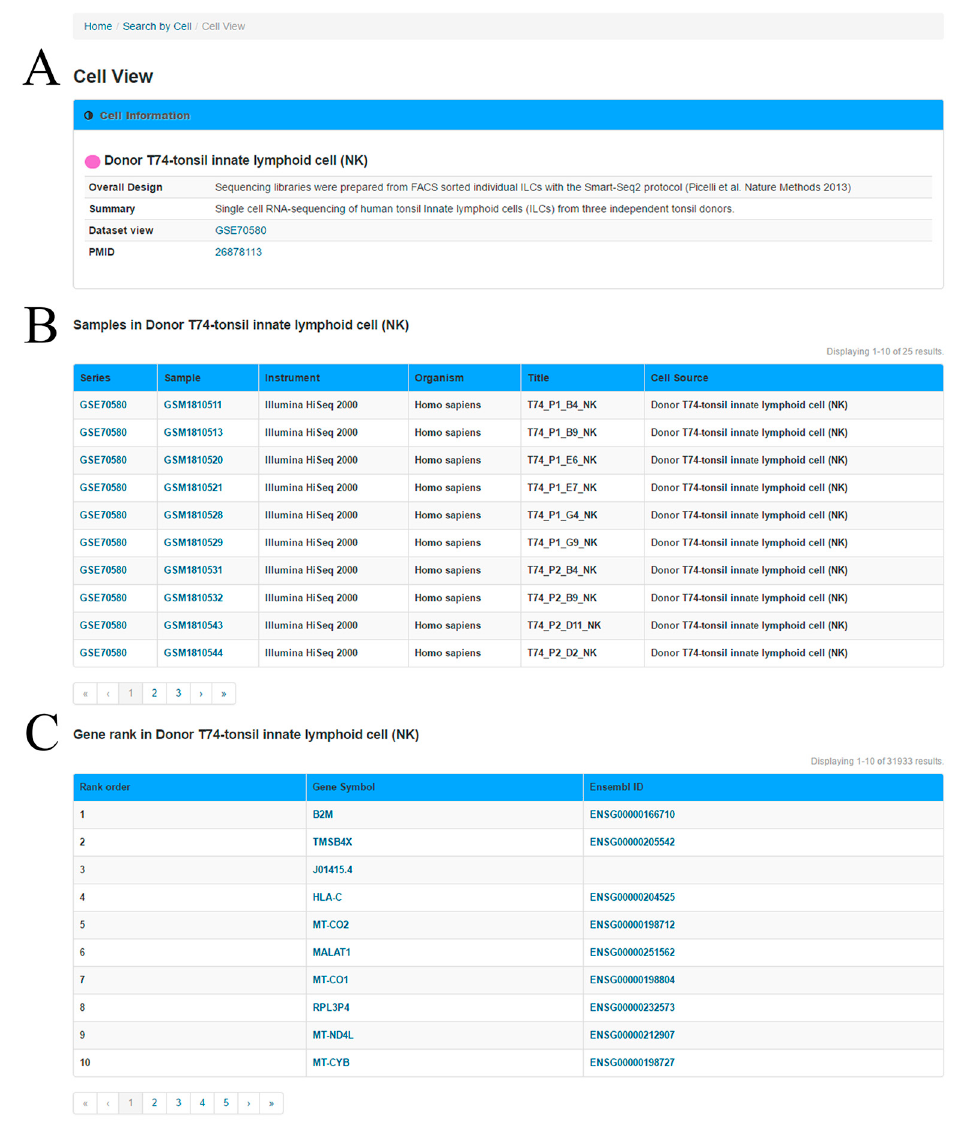
Figure 3. Cell View, displaying tonsil innate lymphoid cell (NK) information as an example. ( A ) Summary information; ( B ) Metadata of cell samples; ( C ) The top 200 upregulated genes and correlation matrices for these genes for the specific cell type or group. Note that multiple pages will be displayed when the sample or gene list is long.